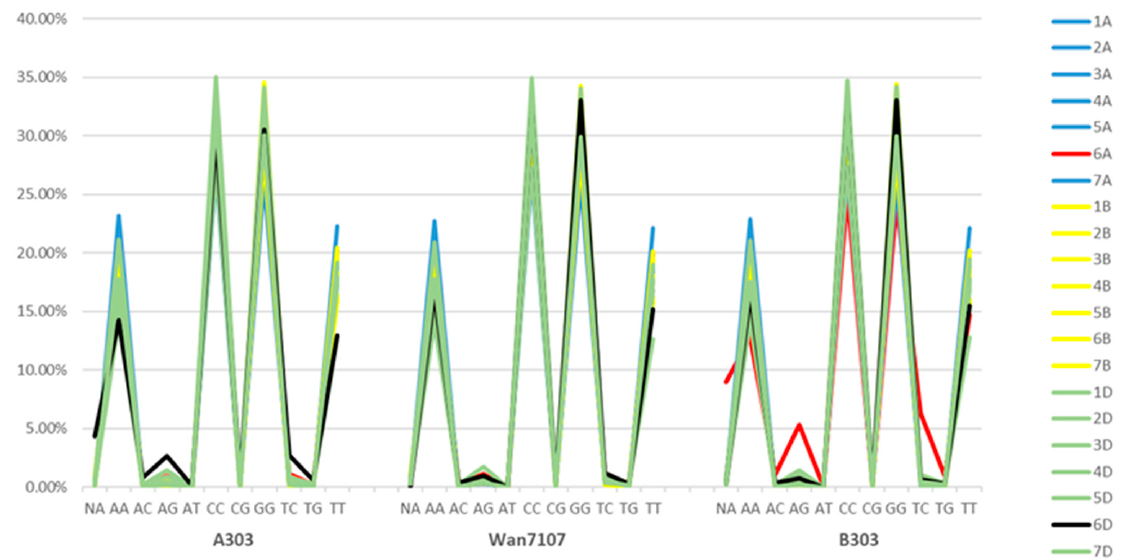
Figure 3. Percentages of genotypes on the 21 chromosomes in A303, Wan7107, and B303. Chromosome 6A is shown in red and chromosome 6D is shown in black.